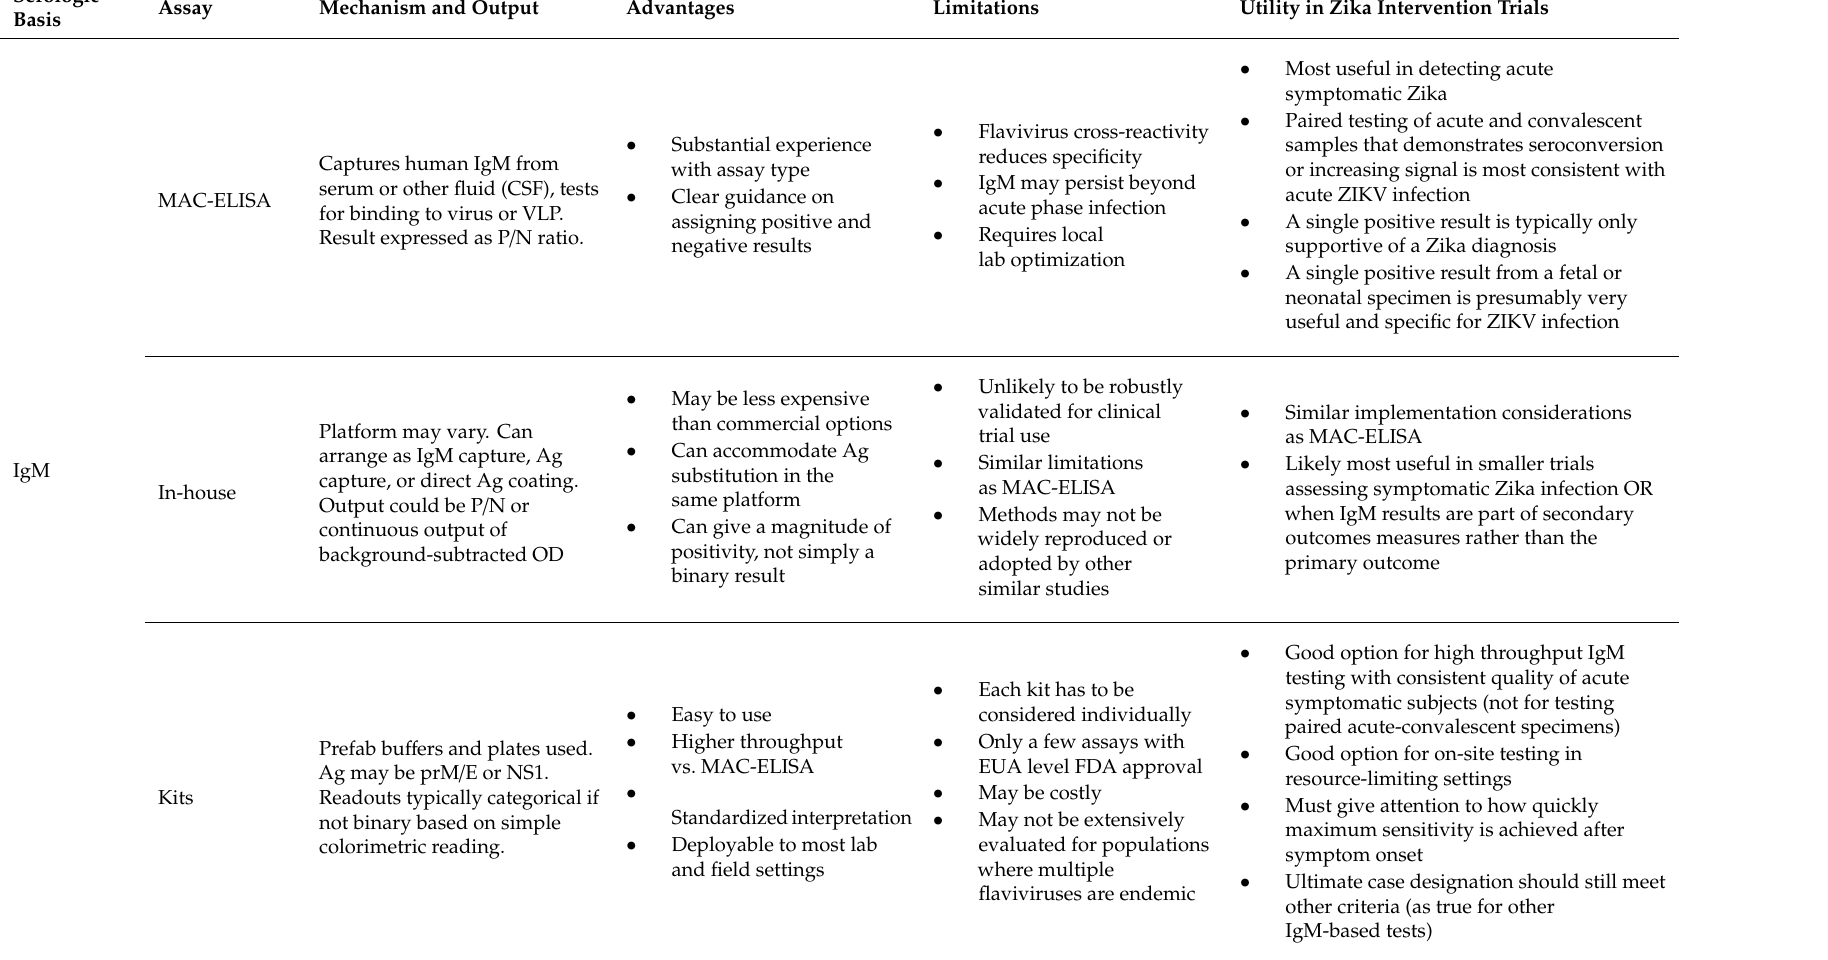
Table 1. Salient features of serologic assays for diagnosing ZIKV infection and considerations for assay selection. Serologic